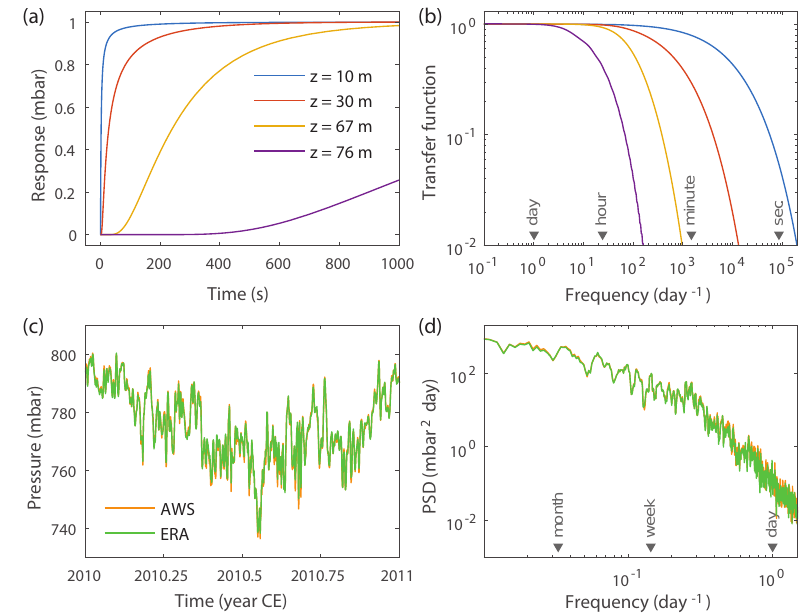
Figure 3. Propagation of pressure variations into the firn at WAIS Divide. (a) Pressure response at indicated depths to a unit-step surface pressure increase of 1mbar at time t = 0. (b) Low-pass filter characteristics of the firn column to surface pressure variability. (c) Surface pressure history of year 2010 at the WAIS Divide site from AWS measurements (orange) and from the ERA-Interim reanalysis (green). (d) power spectral density (PSD) of the time series shown in (c)